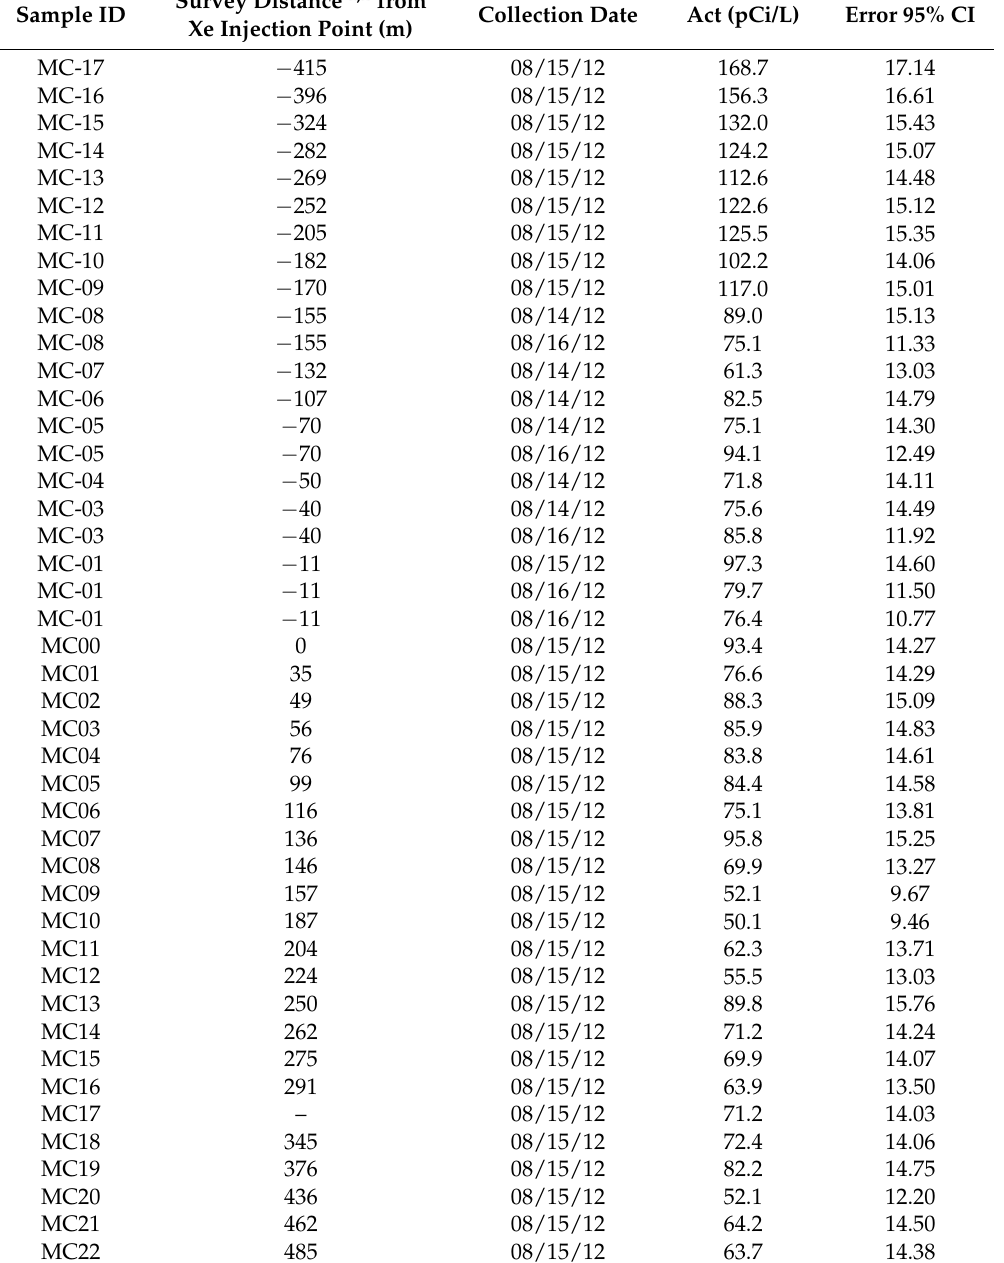
Table 1. Downstream survey of measured 222 Rn activity levels in Martis